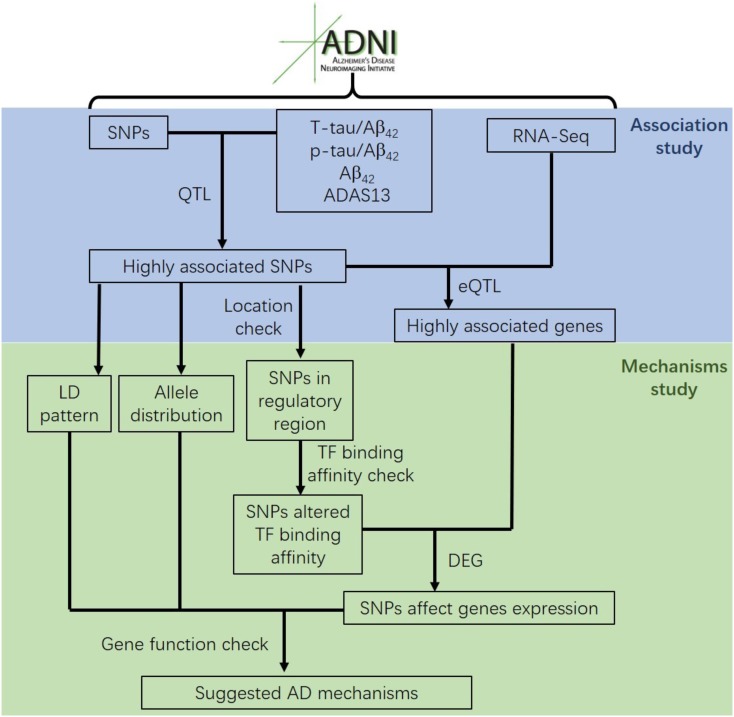
The flow chart of the analysis conducted in this study.